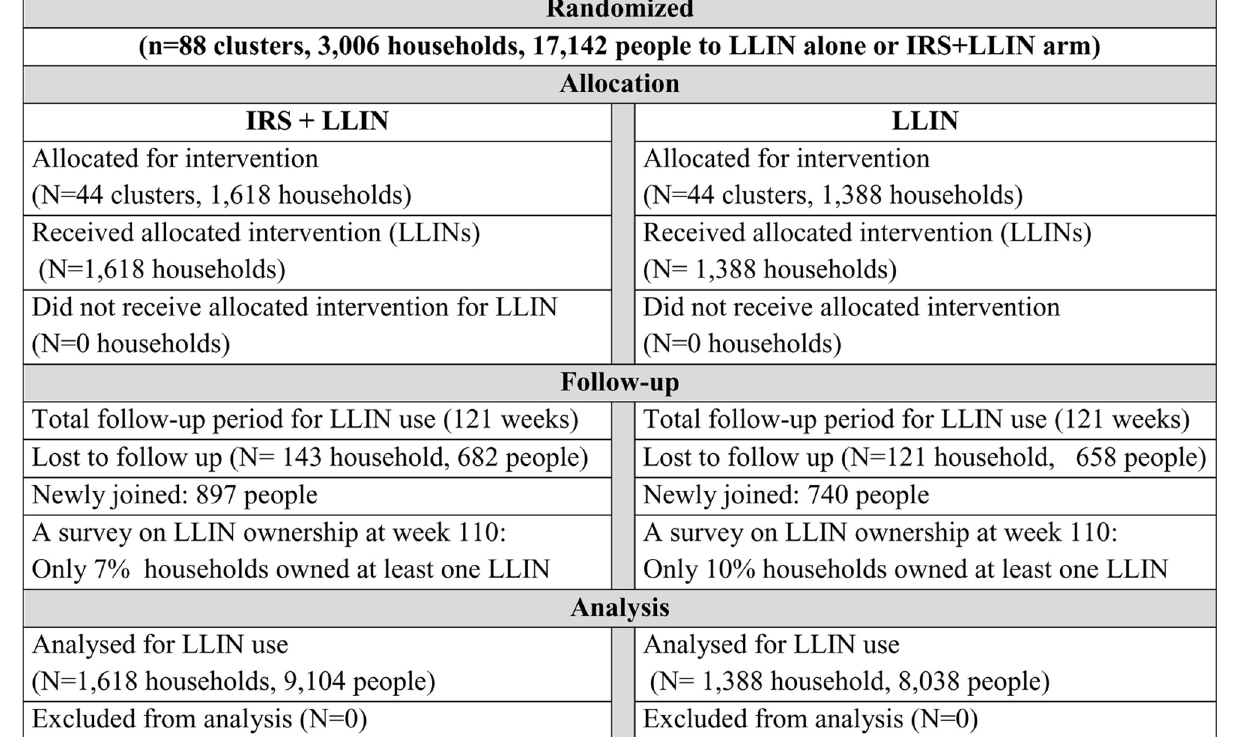
PLOS ONE | https://doi.org/10.1371/journal.pone.0210578 January 10,